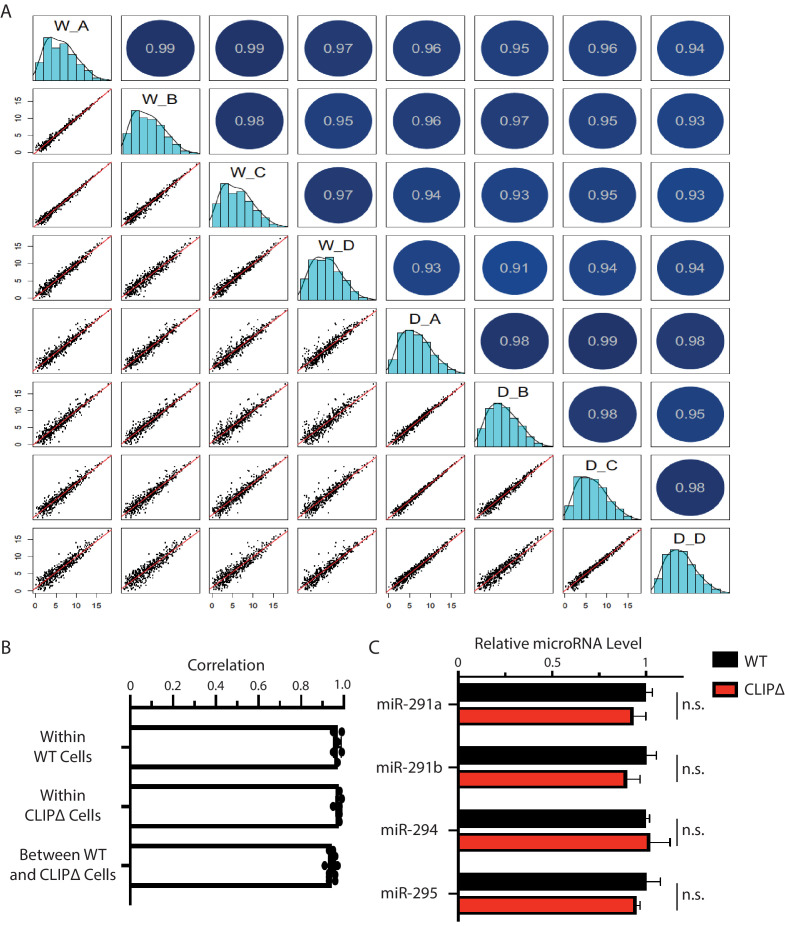
The loss of Trim71-mediated repression of Ago2 mRNA translation does not alter global miRNA in mouse embryonic stem cells (mESCs).(A) The relative miRNA expression pattern is highly similar between the WT and the CLIPΔ mESCs. Scatter plots show pairwise comparisons of the miRNA levels (log2 reads per million mapped reads, RPM) for annotated miRNAs from the four biological replicates. (B) Correlations of global miRNA expression patterns in the WT and the CLIPΔ mESCs determined by small RNA-seq from the four sets of biological replicates. (C) The relative levels of miRNAs. U6 RNA was used for normalization. The results represent the means (± SD) of three independent experiments. n.s. not significant (p>0.05) by the Student’s t-test.